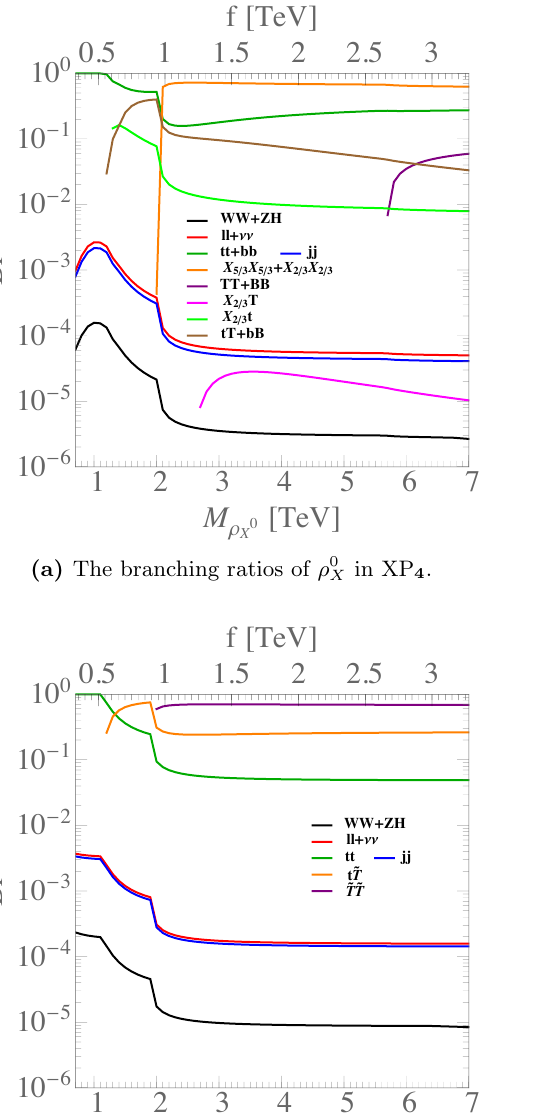
in XP 1 . (d) The branching ratios of (cid:26) 0 X